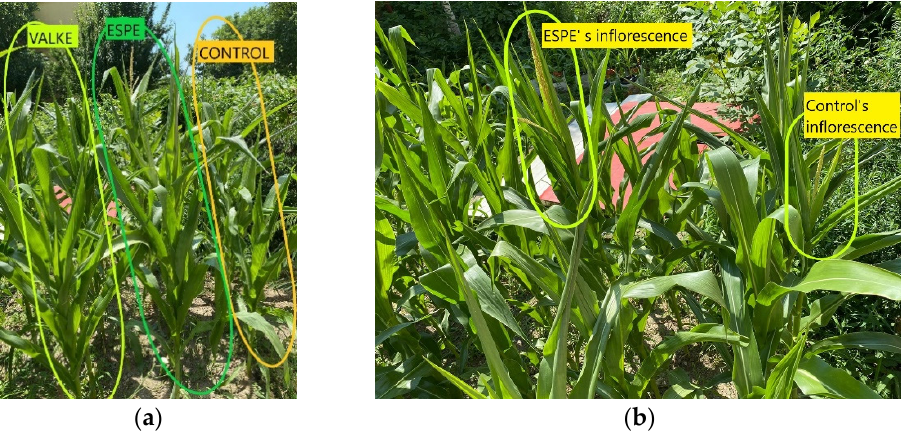
Figure 9. (a ) The higher maize plants foliar fertilised with ESPE and VALKE products compared to the control maize plant; ( b ) the more developed inflorescence of maize plant treated with the ESPE product compared to the control plant.